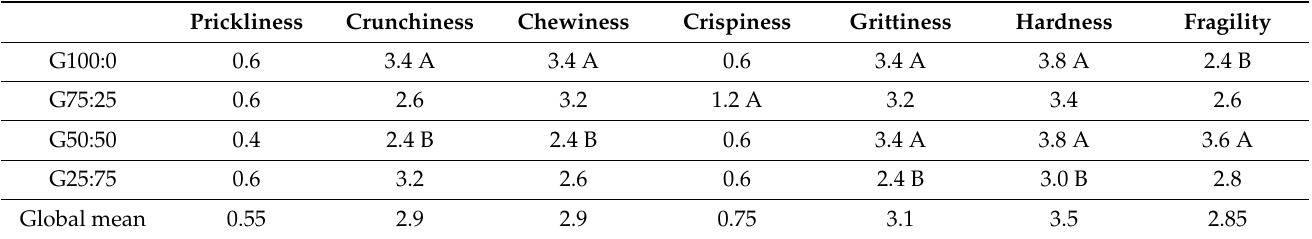
Table 7. Adjusted means for each sample–attribute combination from the analysis of variance mod- els. Letter “A” indicates values significantly higher than the global mean and letter “B” indicates values significantly smaller than the global mean. G100:0 = 100% CF/0% RF; G75:25 = 75% CF/25% RF; G50:50 = 50% CF/50% RF; G25:75 = 25% CF/75% RF.